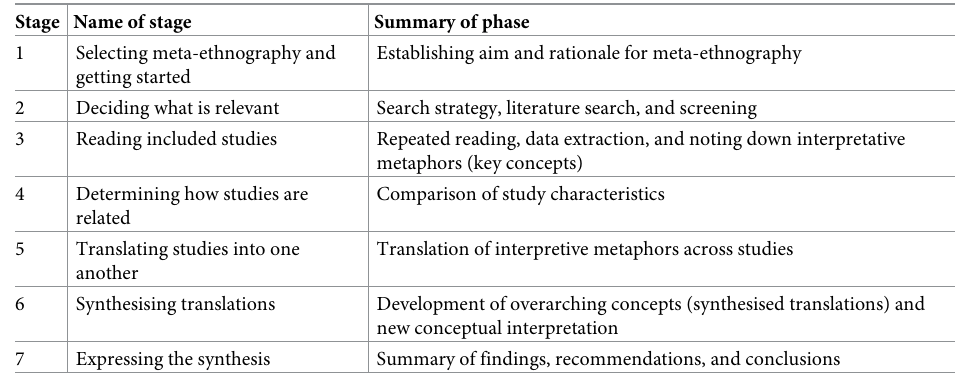
Table 1. Seven stages of meta-ethnography [39]. AU : PerPLOSstyle ; boxesshouldnotbecellbased : Hence ; Box 1 hasbeenchangedtoTable 1 andtablecitationshavebeenrenumbered : Stage Name of